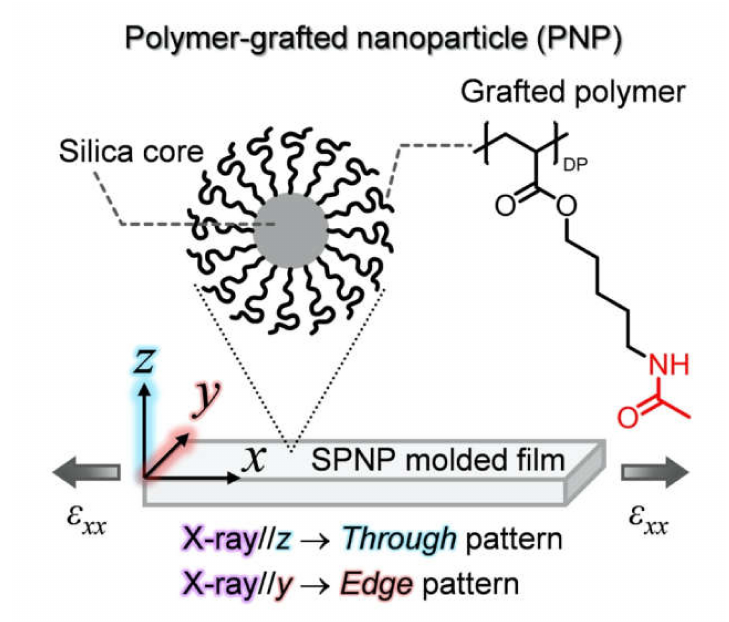
Figure 2. Illustration of the single-component polymer-grafted nanoparticle (SPNP) molded thin film and the chemical structure of the grafted polymer. The x , y , and z axes in the Cartesian coordinates are defined as the stretching direction, width direction, and thickness direction of the film, respectively. The stretching direction is indicated by the thick arrows (elongation stain ε xx )). The X-ray beam is irradiated perpendicular to the through ( xy ) and edge ( xz ) planes, respectively. Reproduced with permission [19]. Copyright 2016, IUCr.